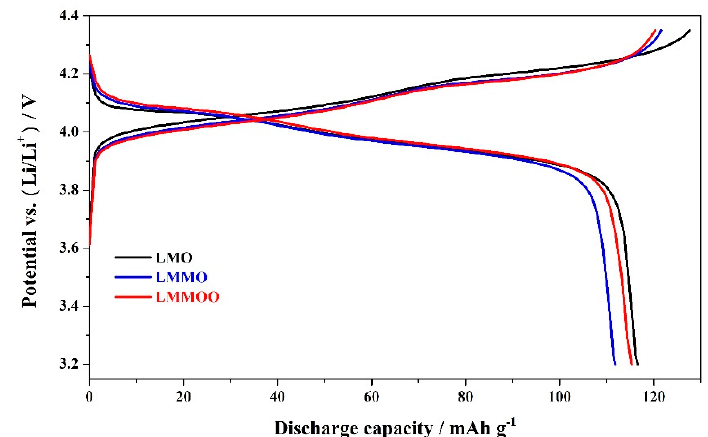
Figure 2. SEM images of ( a ) Mn 3 O 4 octahedra, ( b , c ) LiMn 1.95 Mg 0.05 O 4 octahedra, ( d ) LiMn 2 O 4 , and ( e ) LiMn 1.95 Mg 0.05 O 4 .